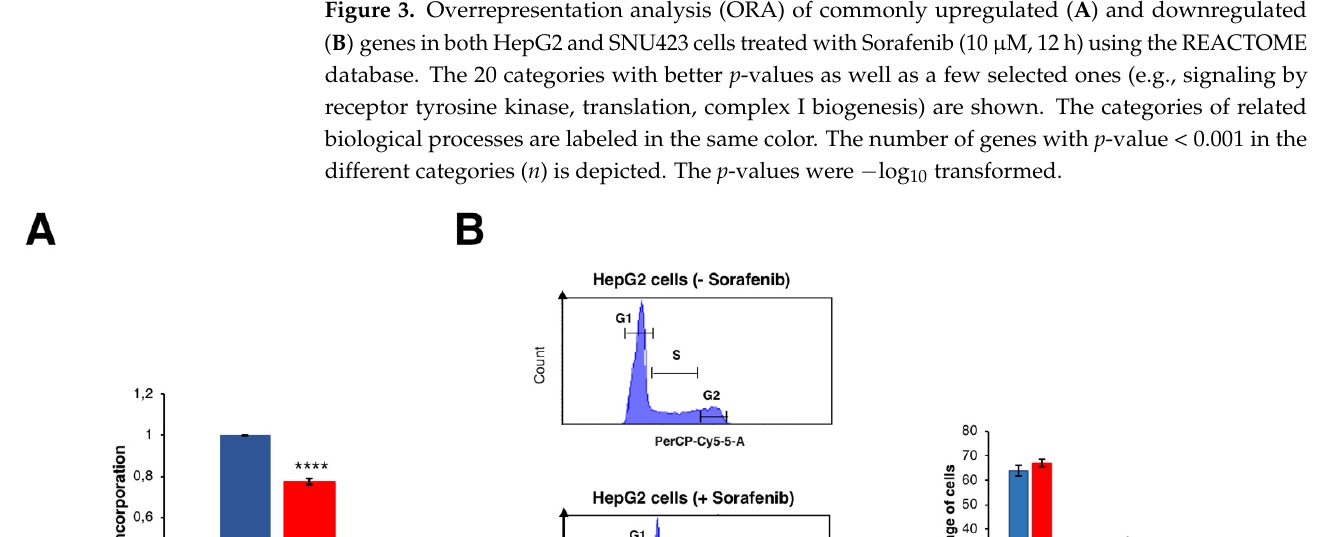
Figure 3. Overrepresentation analysis (ORA) of commonly upregulated ( A ) and downregulated ( B ) genes in both HepG2 and SNU423 cells treated with Sorafenib (10 µM, 12 h) using the REACTOME database. The 20 categories with better p -values as well as a few selected ones (e.g., signaling by receptor tyrosine kinase, translation, complex I biogenesis) are shown. The categories of related bi- ological processes are labeled in the same color. The number of genes with p -value < 0.001 in the different categories ( n ) is depicted. The p -values were − log 10 transformed.